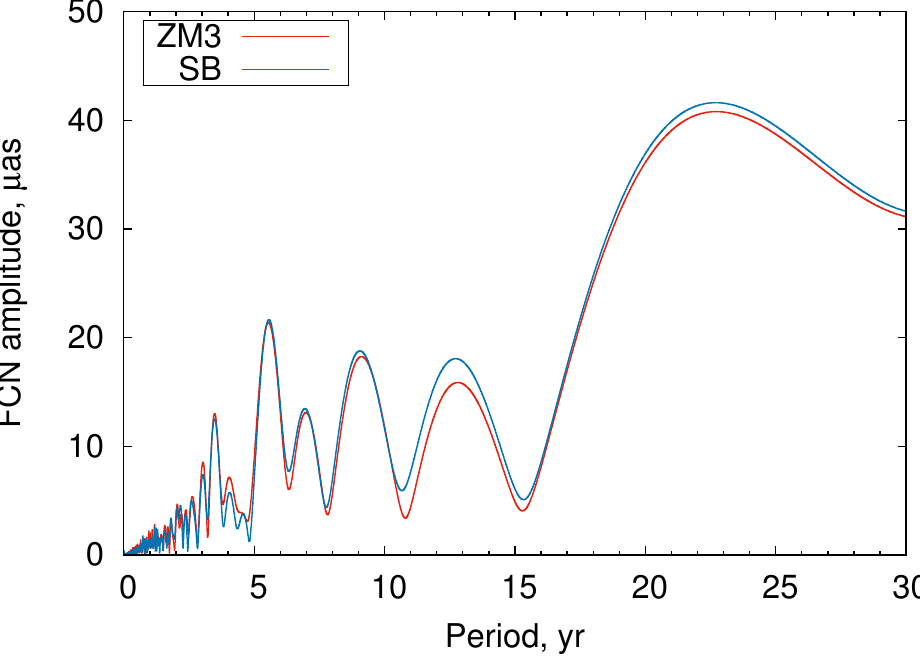
Figure 6. Spectrum of the FCN amplitude time